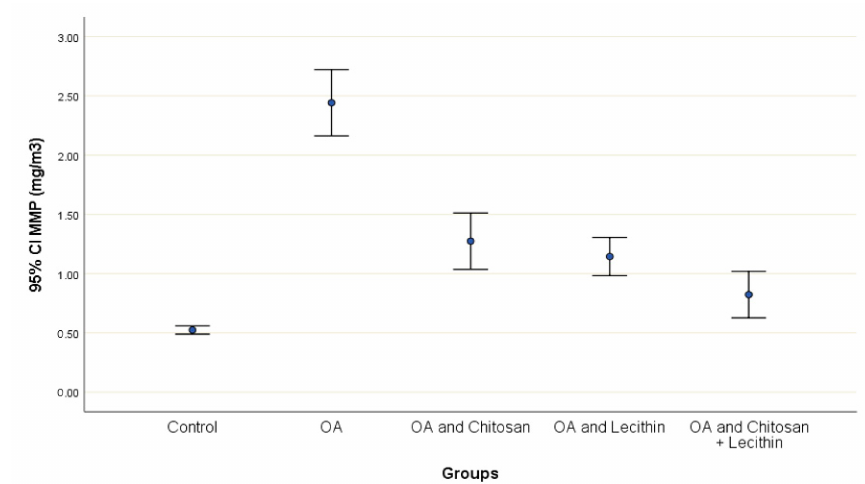
Figure 6. The e ffi cacy of chitosan and lecithin against mitochondrial membrane potential (MMP) in (OA) model induced by monoiodoacetate (MIA) in male rats. The data presented as mean ± S.